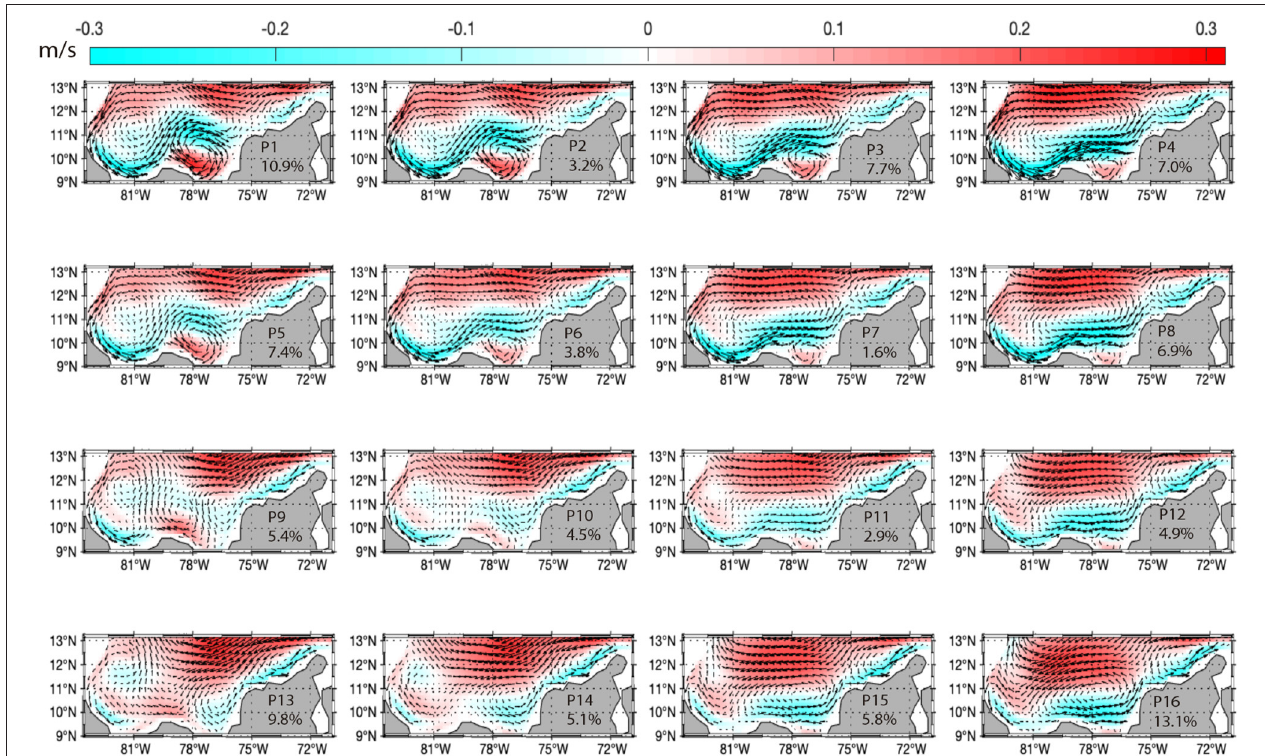
FIGURE 11 | Spatial patterns of HYCOM model ocean currents at 100 m depth given by a 4X4 SOM analysis in the Caribbean Sea computed from weekly mean surface velocities over the time period 2007–2012. The colorbar indicates the magnitude of the zonal component of velocity in m · s − 1